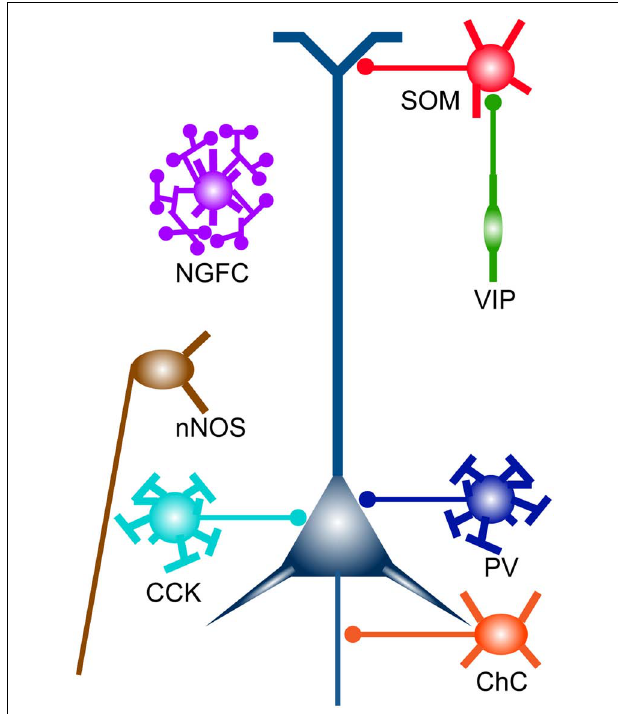
FIGURE 1 | Cortical GABAergic interneuron subtypes. Broad subtypes of cortical GABAergic interneurons, which are characterized by gene expression and unique subcellular innervation. Distinct subcellular compartments of an excitatory pyramidal neuron (in indigo blue) are innervated by different classes of GABAergic interneurons (e.g., PV and CCK neurons, soma targeting; SOM neurons, dendrite targeting; ChCs, axon targeting). ChC, chandelier cell; NGFC, neurogliaform